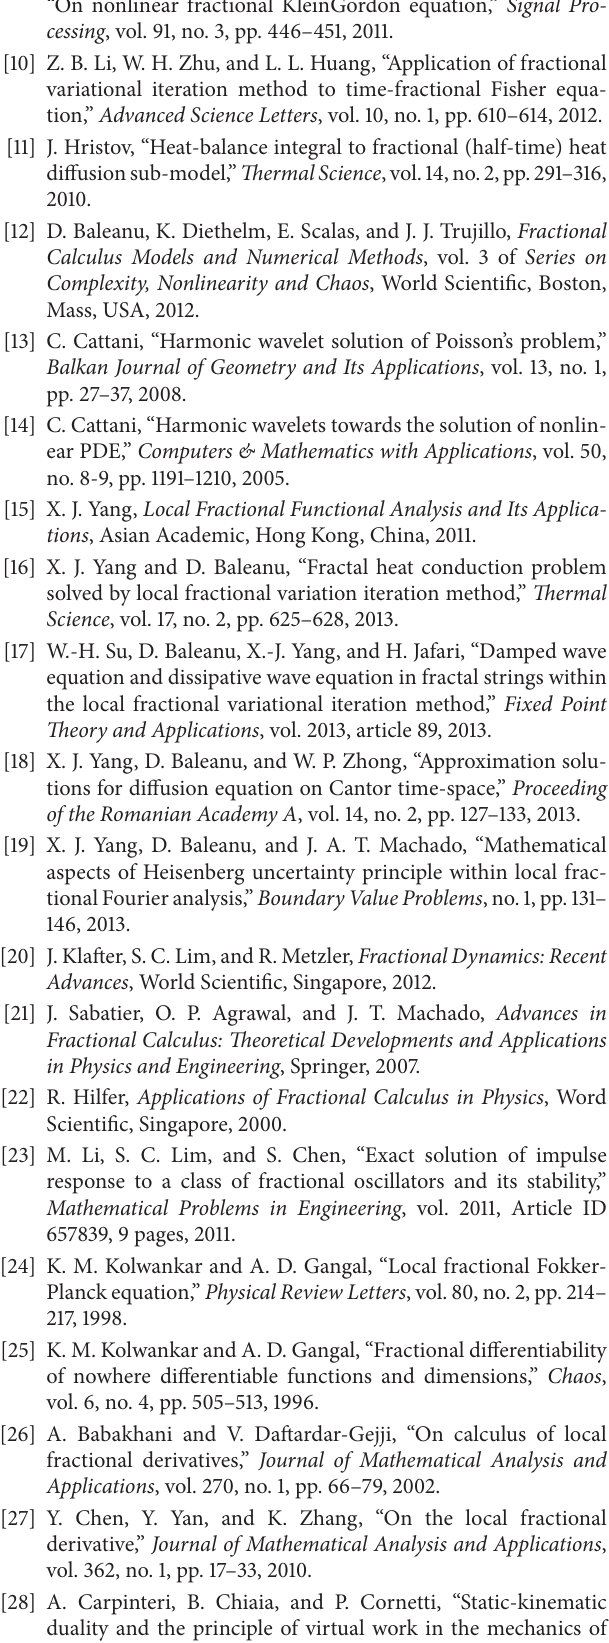
Figure 1: Graph of 𝑢(𝑥,𝑡) for 𝛼 = ln 2/ ln 3 .